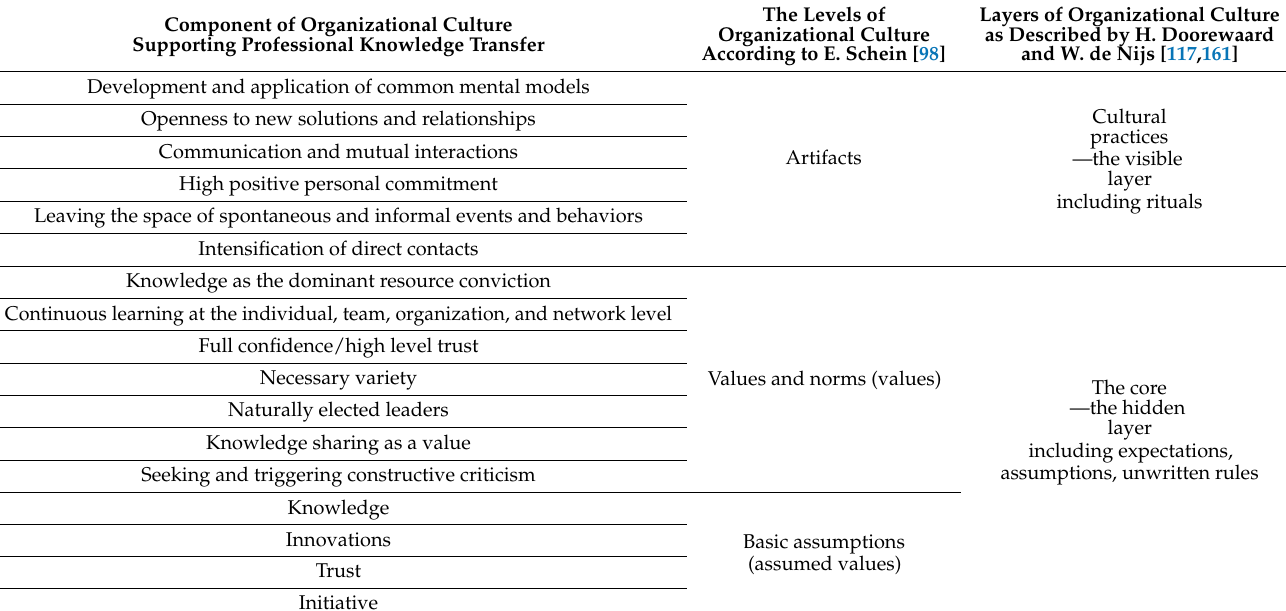
Table 3. The identified components of the organizational culture supporting the knowledge transfer of IT professionals in the energy sector and their place in the well-known concepts of organizational culture